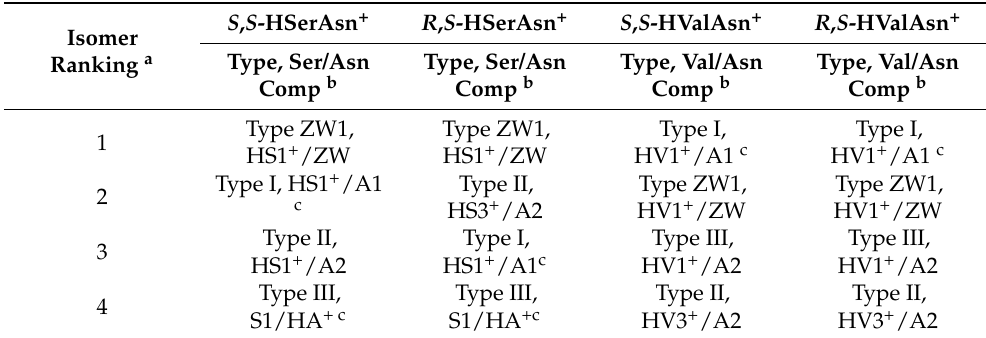
Table 1. The monomeric composition of the lowest energy isomers of each type for the four binary species studied.